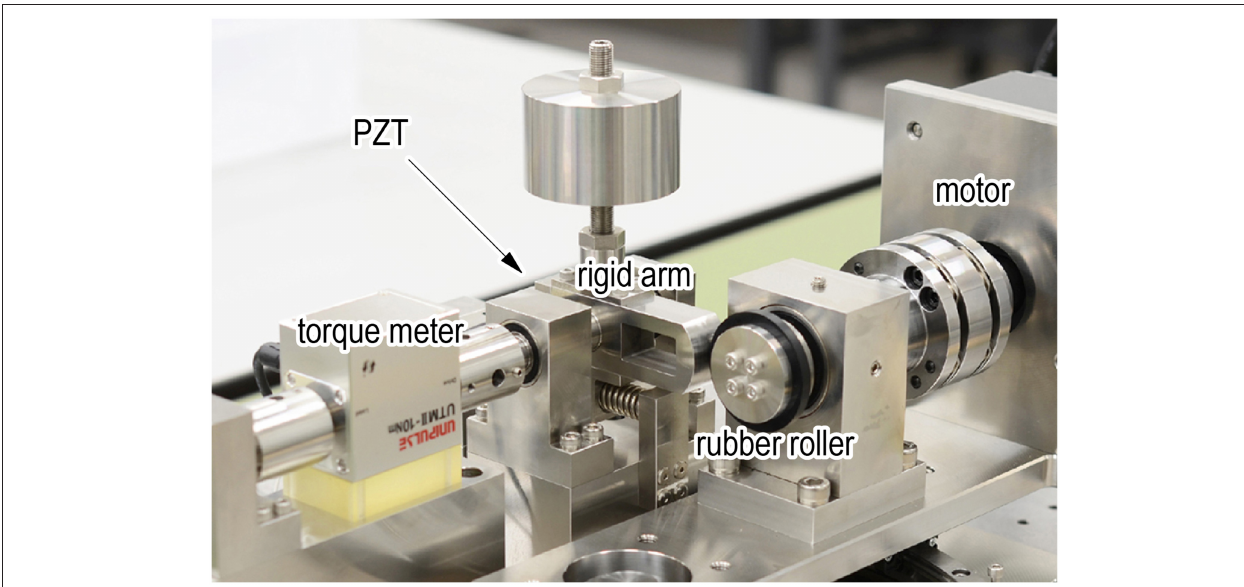
FIGURE 4 | Apparatus developed for measuring dynamic response of rubber in sliding contact.